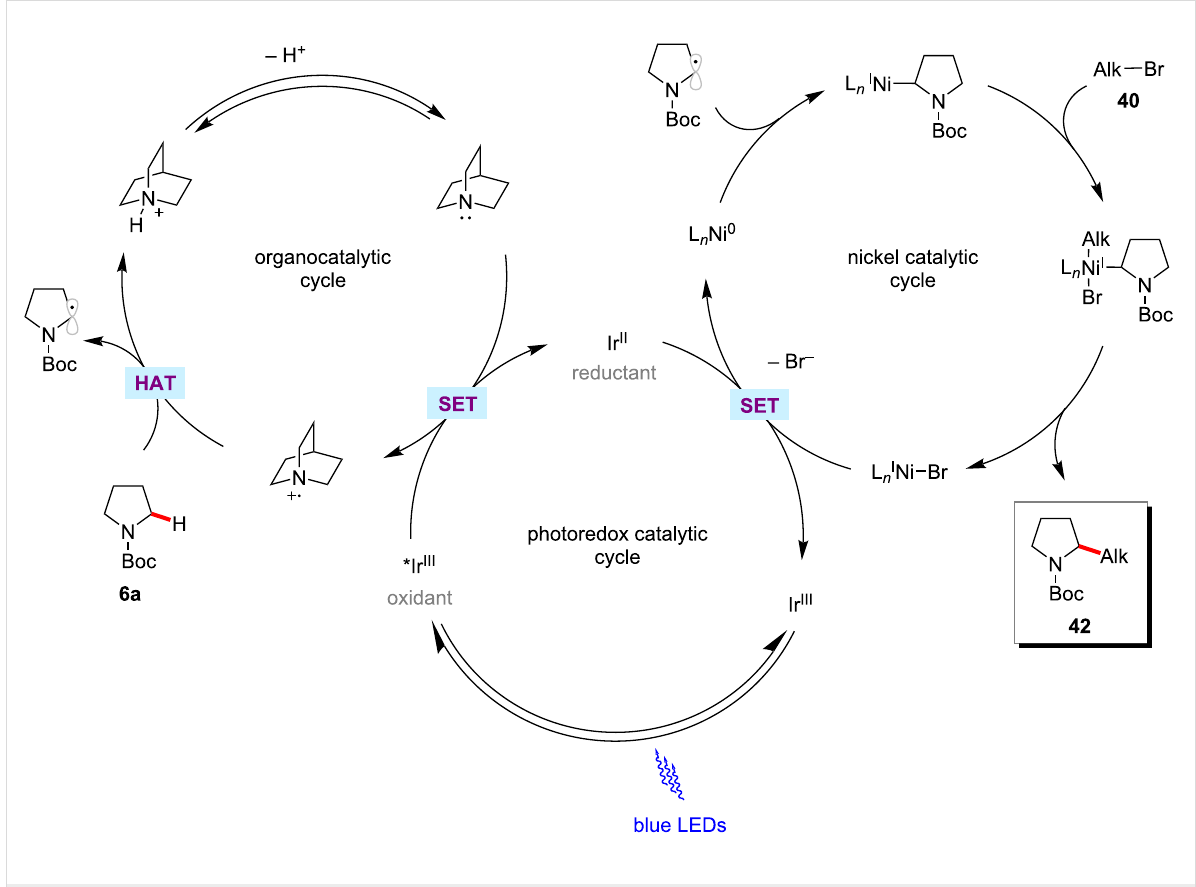
Figure 12: Proposed mechanism for photoredox nickel-catalyzed C(sp 3 )–H alkylation via polarity-matched HAT.